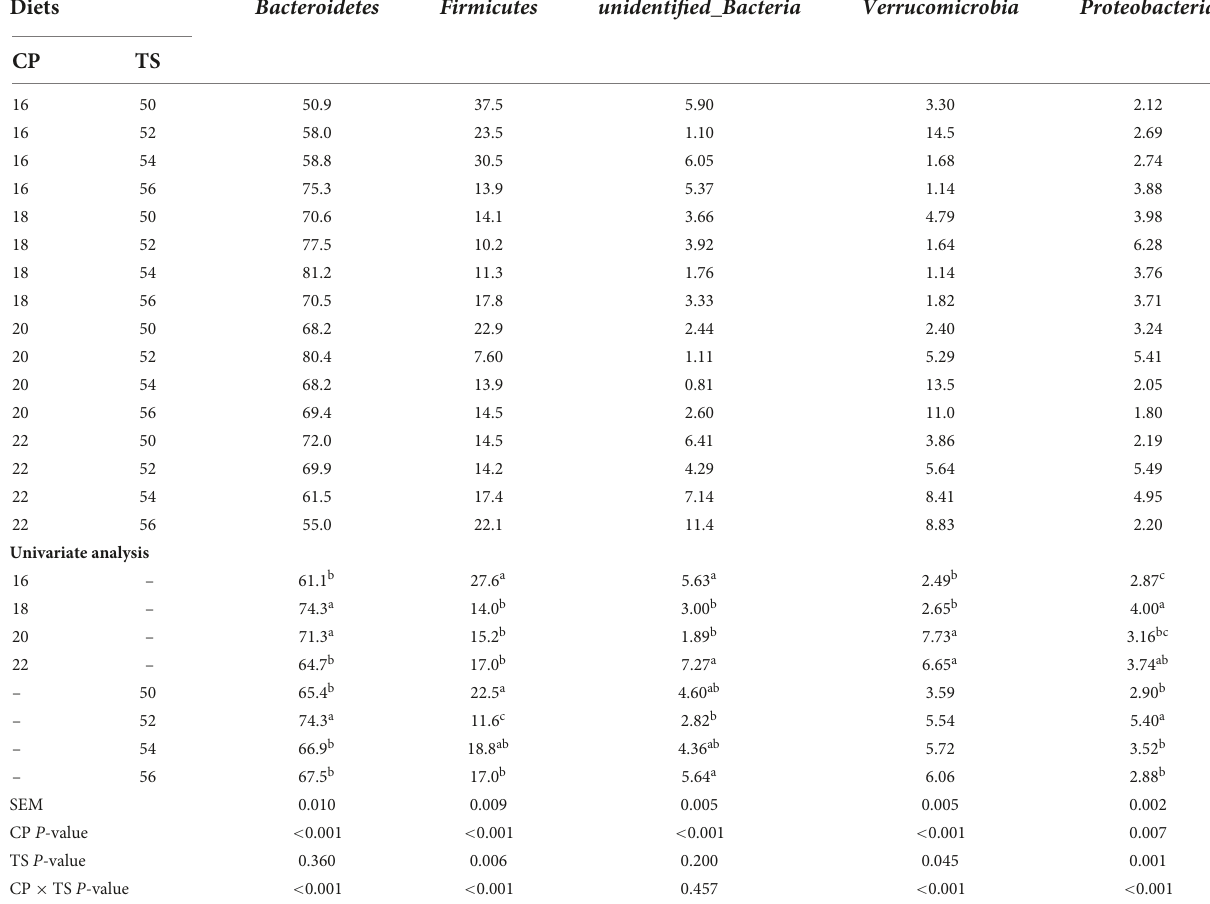
TABLE 2 Phylum-level composition ( > 1%) on the fecal bacterial community of mice fed different starch and protein ratio diets. Diets Bacteroidetes Firmicutes unidentified_Bacteria Verrucomicrobia